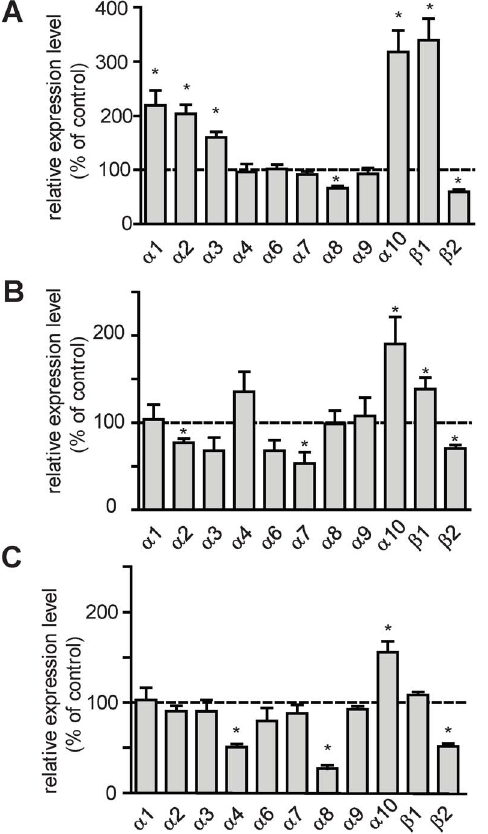
Figure 7. Expression levels of nAChR mRNA subunits after neonicotinoid exposure. Experiments were assessed on whole survivingl larvae exposed to neonicotinoids at LC 50 for 48h. Aphids were intoxicated with imidacloprid (A) thiamethoxam (B) or clothianidin (C). Each qPCR experiment was performed in triplicate and results are represented as the mean of four to seven independent experiments after normalization with actin and ribosomal rpl7 gene. Error bars represent the SEM. Results are expressed in % of the expression level in control conditions (no insecticide, corresponding to 100%). Statistical analysis (t-test, a =0.05) was carried out using Graphpad Prism 5 software.